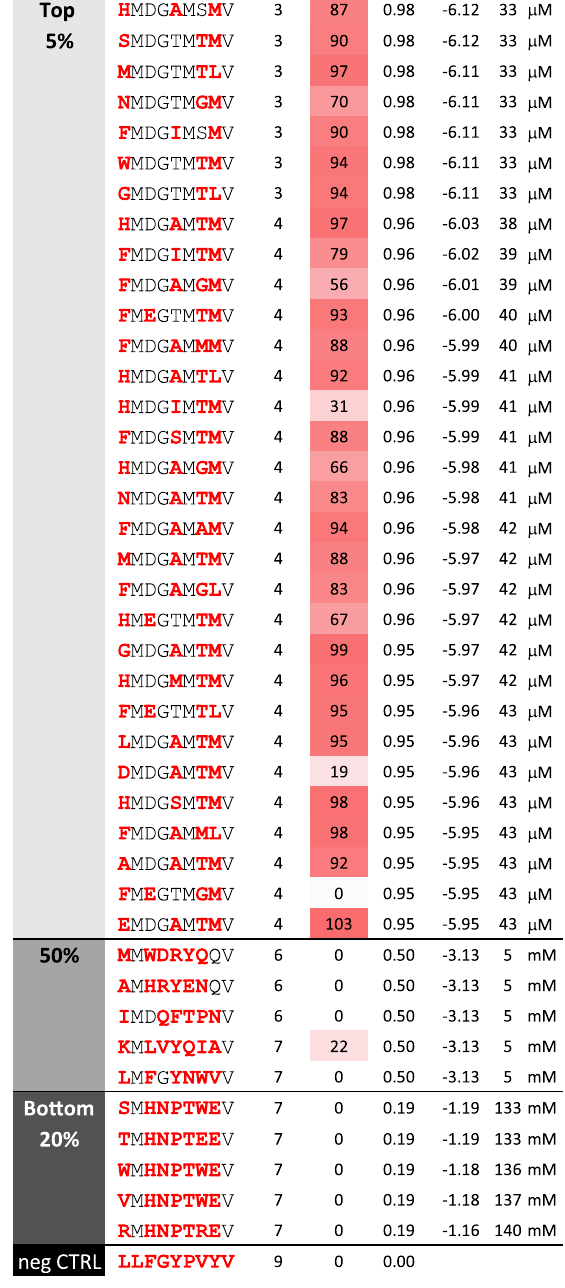
Fig. 6 | Experimental validation of the TIL1383I speci fi city analysis. In total, 72 peptides from the top 5% (scores ≥ 0.95) in the speci fi city analysis in Fig. 5f were selected for evaluation in co-culture experiments measuring IL-2 production. Peptides selected included the 24 highest-scoring peptides with two amino acid changesrelativetothenativeTyr 370D peptide,the24highest-scoringpeptideswith threeaminoacidchanges,andthe24highest-scoringpeptideswithfouraminoacid changes. Five peptides at 50% (scores=0.5, 6 – 7 amino acid changes) were also selected, as were the fi ve lowest-scoring peptides (bottom 20%, scores=0.19, 7